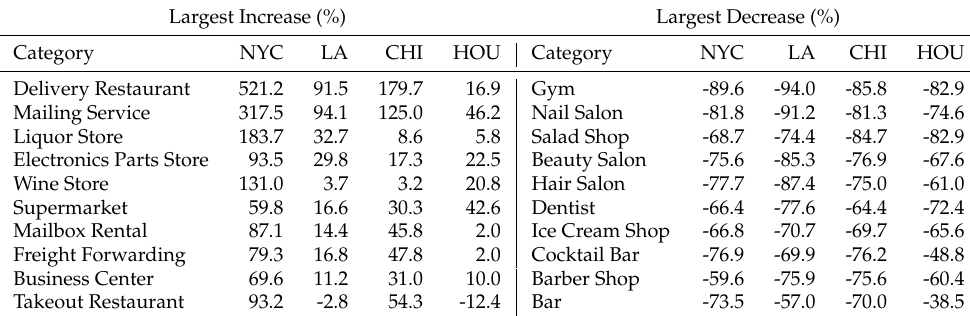
Table 5: Place types that saw the largest percentage increase and decrease over the one year time